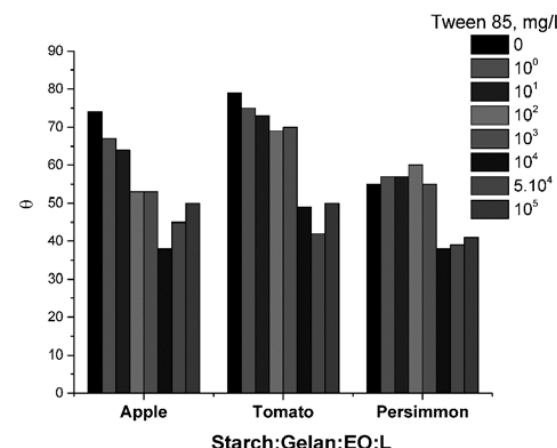
Figure 13. Variation of θ with Tween 85 concentration for three coating mixtures.